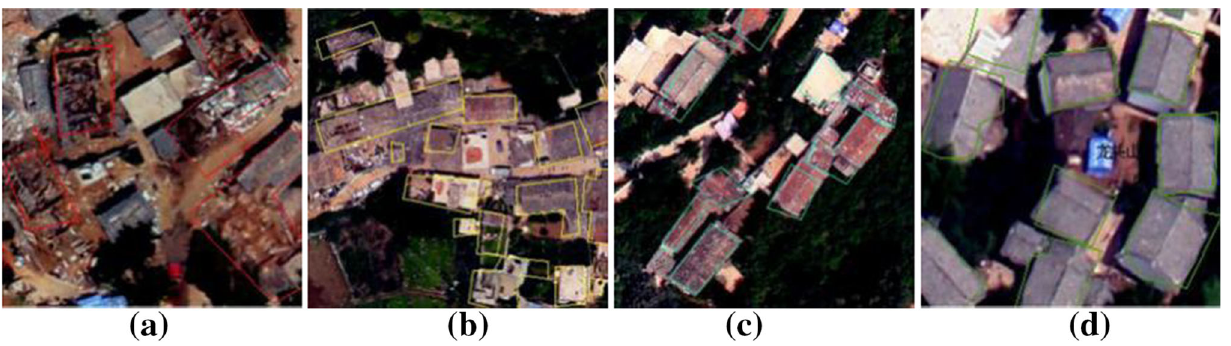
Fig. 6 Building damage interpretation keys (UAV images): Totally collapsed ( a ), Seriously damaged ( b ), Moderately damaged ( c ), Undamaged ( d